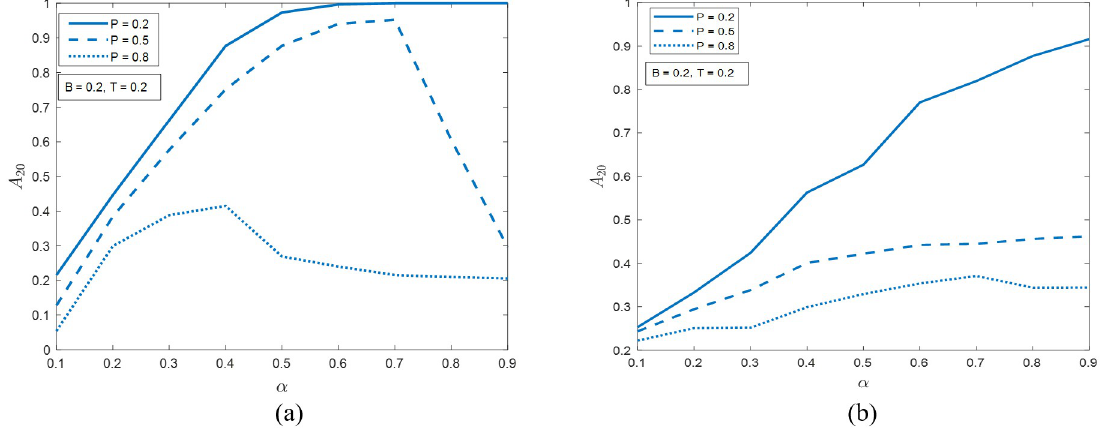
Fig 6. The portion of active nodes at time step 20 when B = T = 0.2 in (a) the ER network and (b) the SF network. The possible values of P are 0.2, 0.5, and 0.8. The values of α are from 0 to 0.9 at step size 0.1.